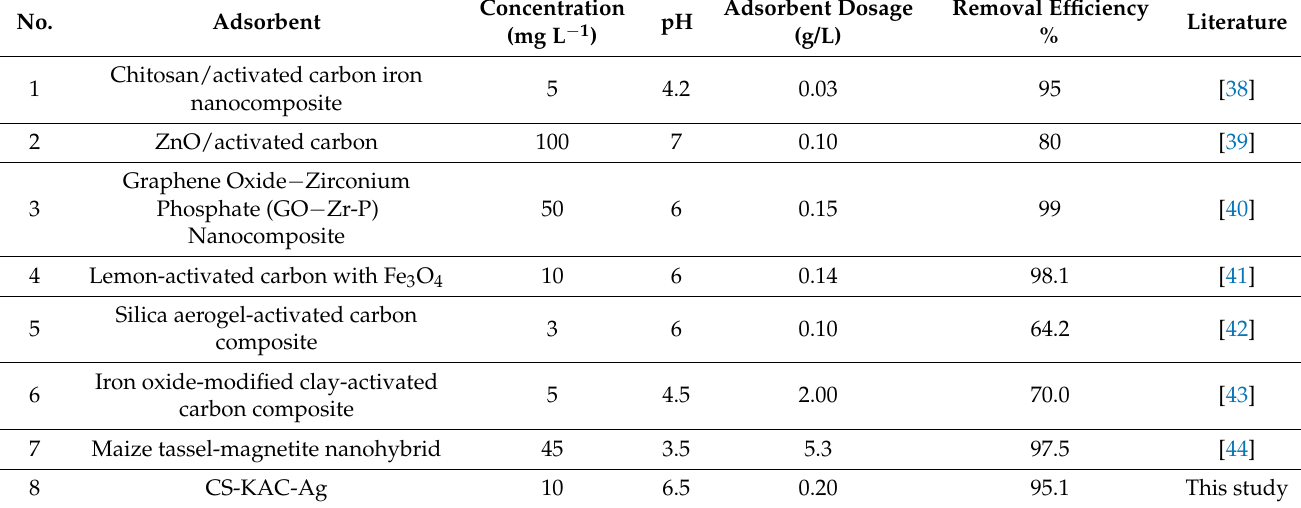
Table 7. Operating values and Cd 2+ removal percentage using